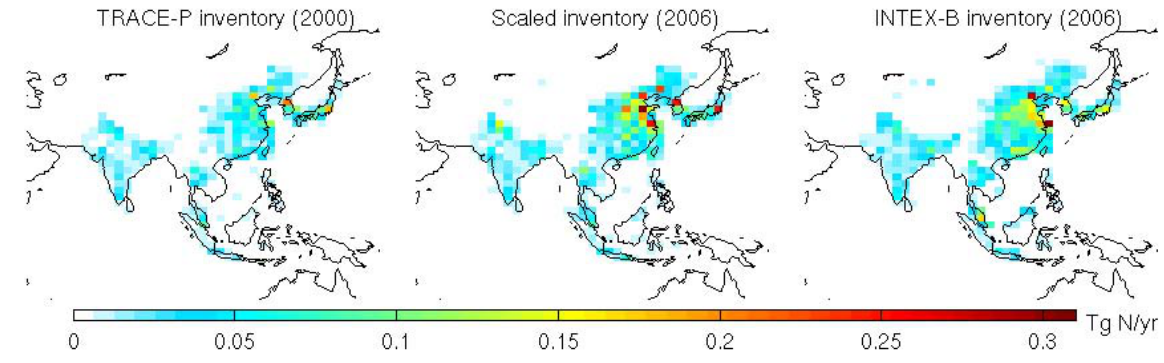
Fig. 3. Development of the Asian anthropogenic NO x emission inventory for the baseline simulation. The left panel shows the standard GEOS-Chem regional inventory for East Asia, compiled for TRACE-P by Streets et al. (2003). The center panel contains the emission inventory after applying a two-stage scaling process using ratios of annual fuel consumption from 2000 to 2003, as well as a linear regression of springtime tropospheric NO 2 columns from SCIAMACHY from 2003 to 2006. The right panel displays a recent NO x emission inventory compiled by Zhang et al. (2009b).